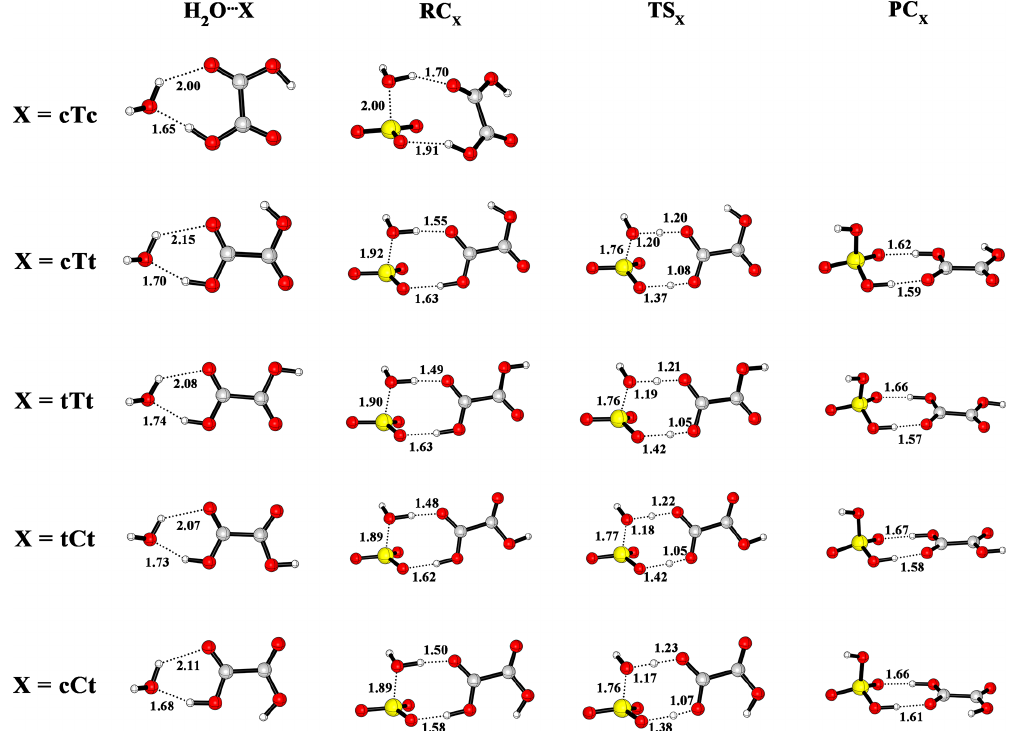
Figure 4. Optimized M06-2X/6-311++G(3df,3pd) structures of reactant complexes, pre-reactive complexes, transition states and post- reactive complexes for the OA-catalyzed SO 3 hydration reaction (distance unit: angstrom. Table 2. Relative rate constants of OA-catalyzed SO 3 hydration with respect to water-catalyzed SO 3 hydration at different altitudes. Altitude